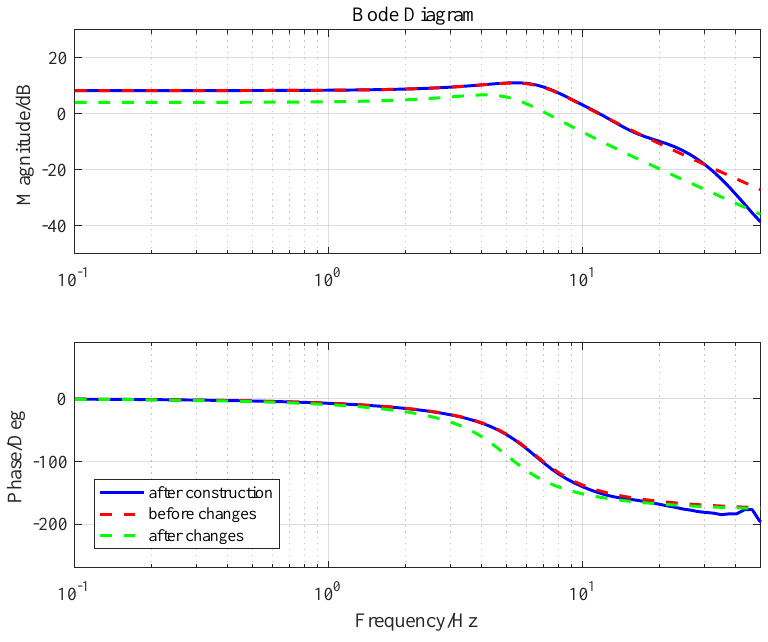
Figure 4. The Bode responses of the plant in simulation.